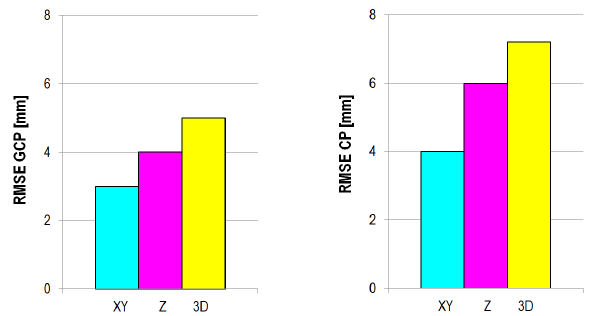
Figure 8. RMSE of 5 GCP (left) and 40 CP (right) after bundle block adjustment